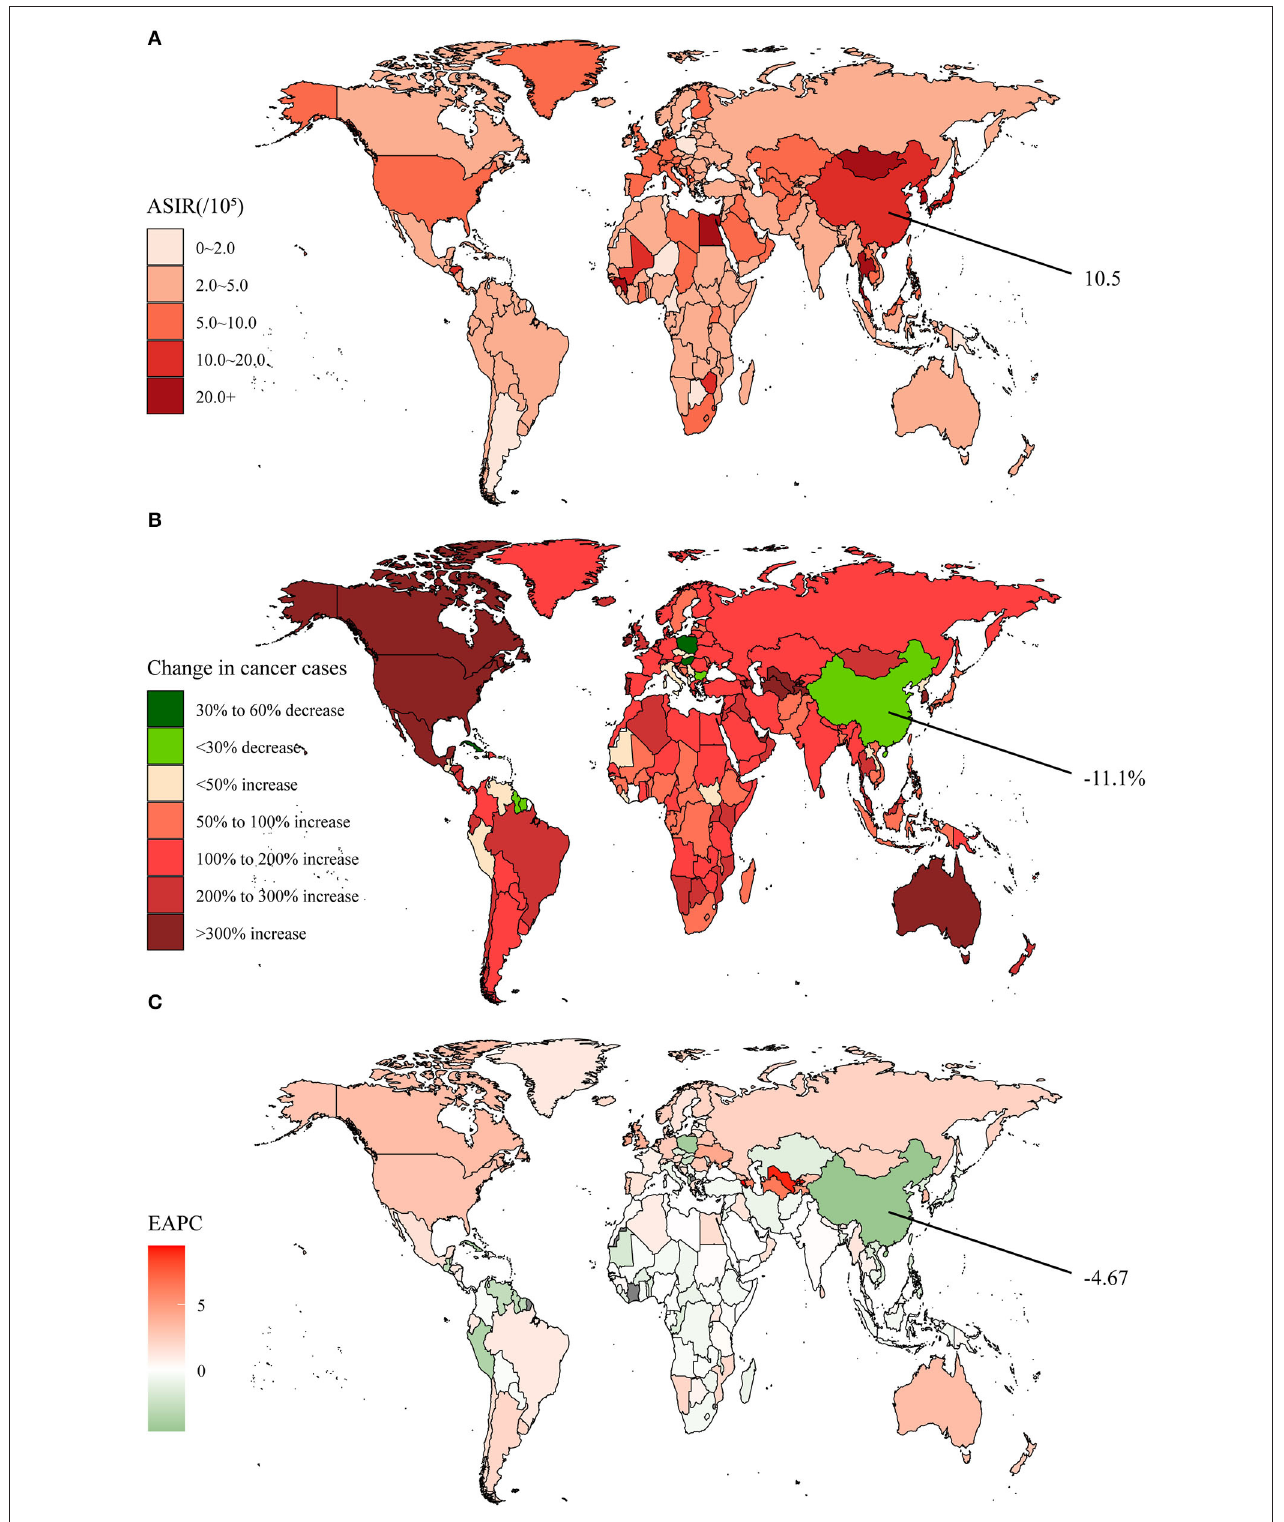
FIGURE 3 | The global disease burden of liver cancer in 204 countries and territories. (A) The ASIR in 2019; (B) The relative change in incident cases between 1990 and 2019; (C) The EAPC of ASIR from 1990 to 2019. Outcomes of China were specifically annotated. ASIR, age-standardized incidence rate; EAPC, estimated annual percentage